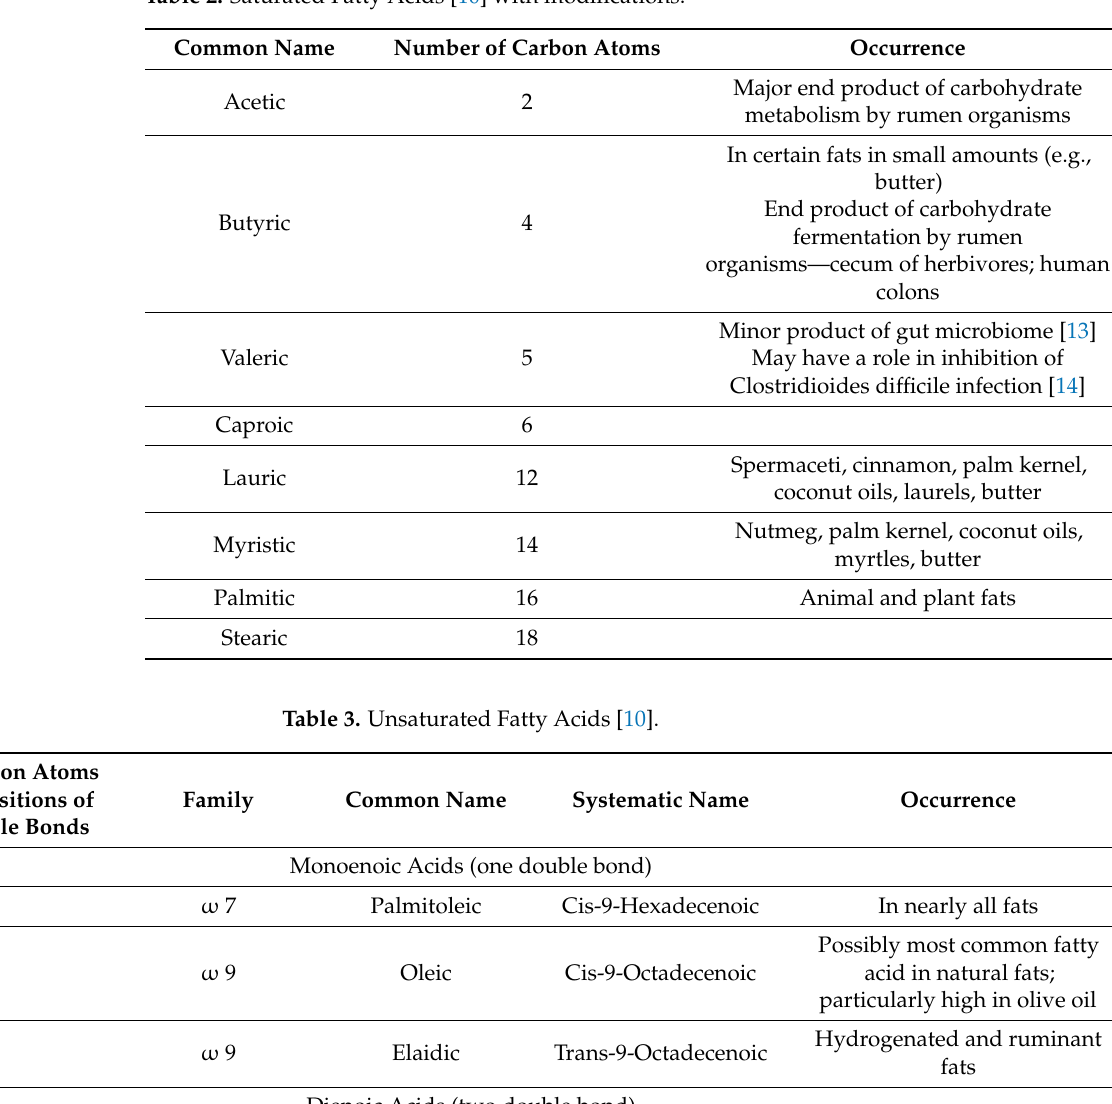
Table 2. Saturated Fatty Acids [10] with modifications.